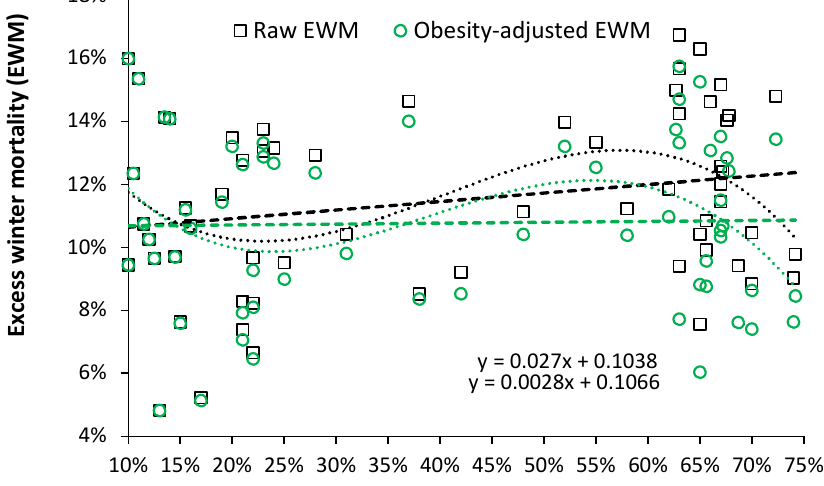
Figure A5. Trend in excess winter mortality (EWM) from winter 1959/60 to 2019/20 versus proportion aged 65+ vaccinated. Trend lines are given for raw EWM and obesity-adjusted-EWM. The effect of obesity was calculated as a time trend which was matched against proportion aged 65+ vaccinated in that year. Obesity was assumed to have no effect during the 1960s, and half the current effect during the 1970s. The non-linear trends are 4th order polynomials to demonstrate that the overall trend may be more complex than a simple linear